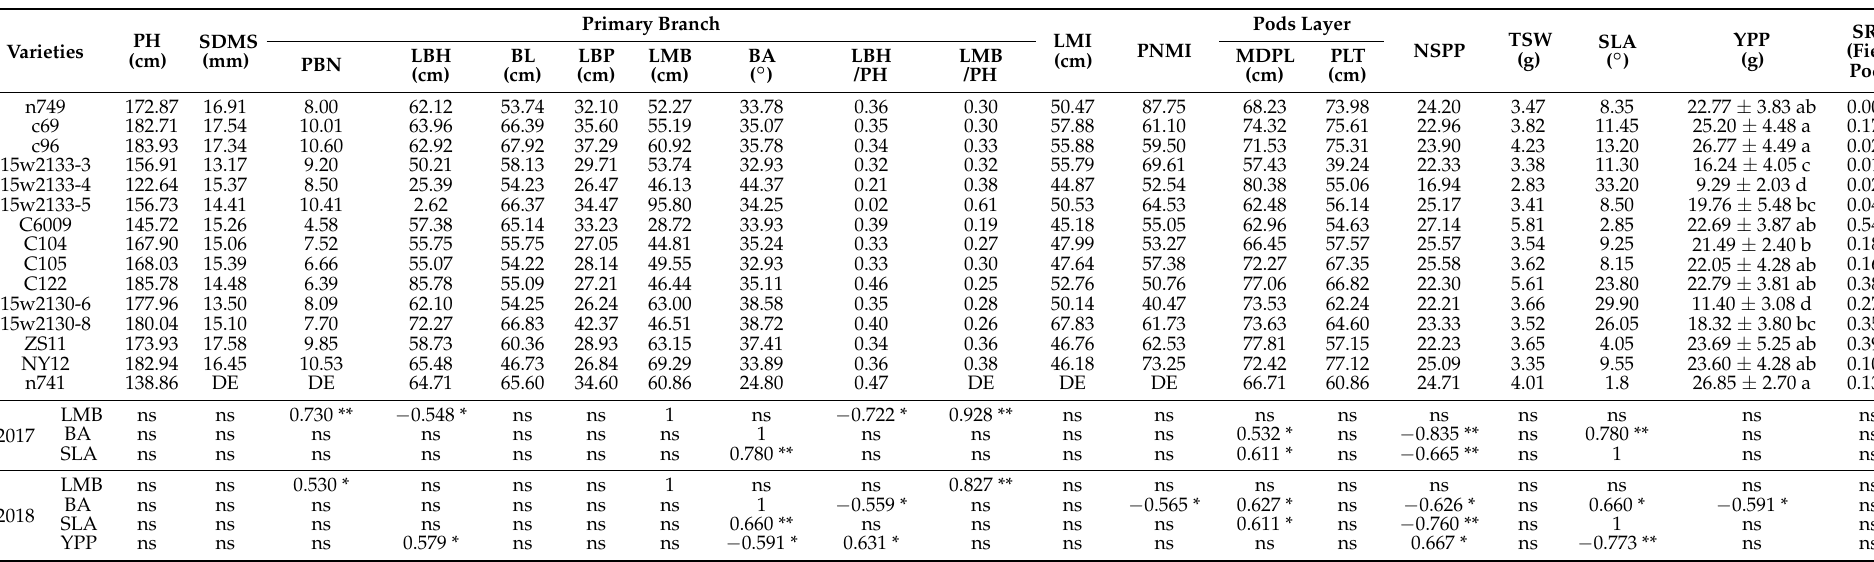
Table 1. Average value of plant type characters and the correlation between important traits of he tested materials in 2017 and 2018.